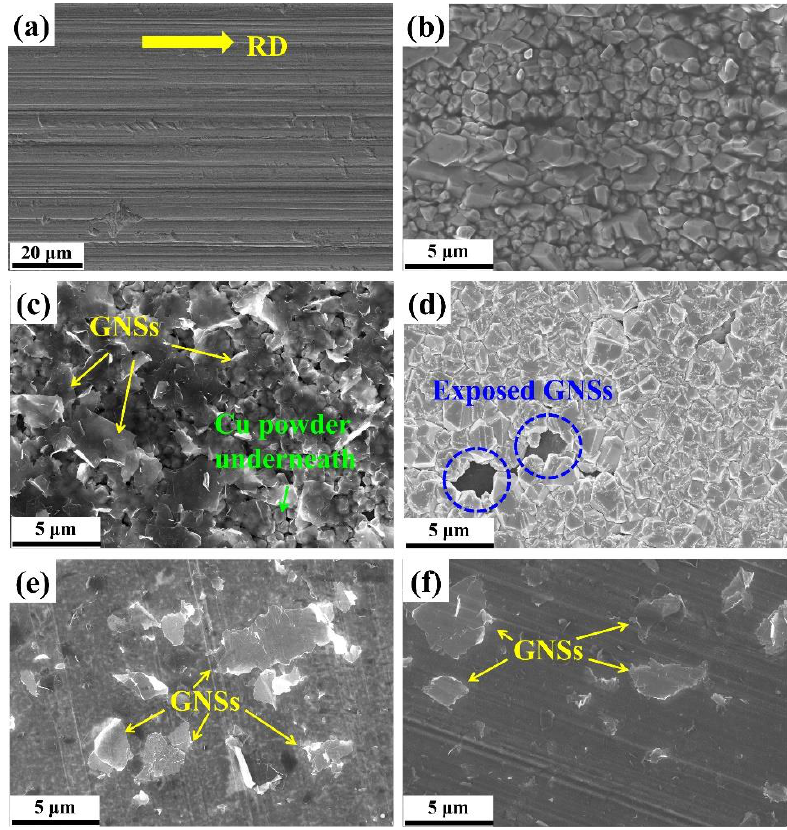
Figure 2. SEM – SE micrographs of ( a ) raw Cu foil, ( b ) Cu particles deposited on raw Cu foil, ( c ) GNSs deposited on Cu particles, ( d ) Cu particles deposited on GNSs, ( e ) 30 μm thick Cu foils deposited with GNSs, and ( f ) 50 μm thick Cu foils deposited with GNSs.